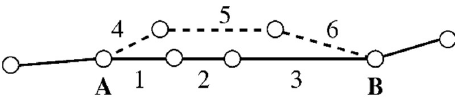
Figure 9. Illustration of the calculation of the total deviation metric for the non-overlapping route section between nodes A and B.